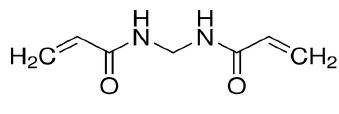
Figure 1. Structural formula of hydrogel components used in this work.